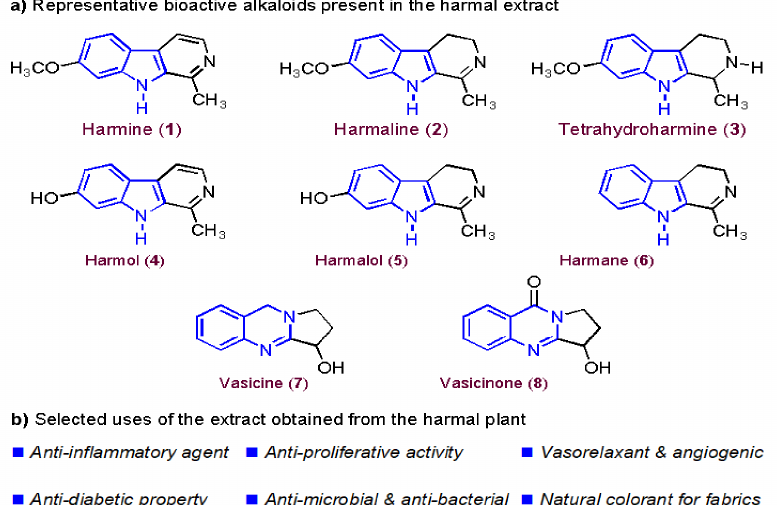
Figure 1. ( a ) Key bioactive indole-, quinazoline- and quinazolinone-based alkaloids present in the extract of the harmal plant and ( b ) generalized selected uses of the harmal extract [21].